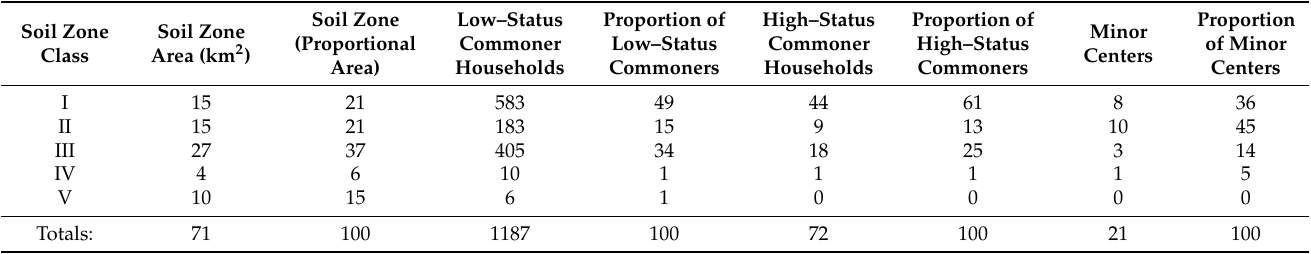
Table 4. Soil zone capability classifications and the counts and proportions of commoner households and minor centers associated with these